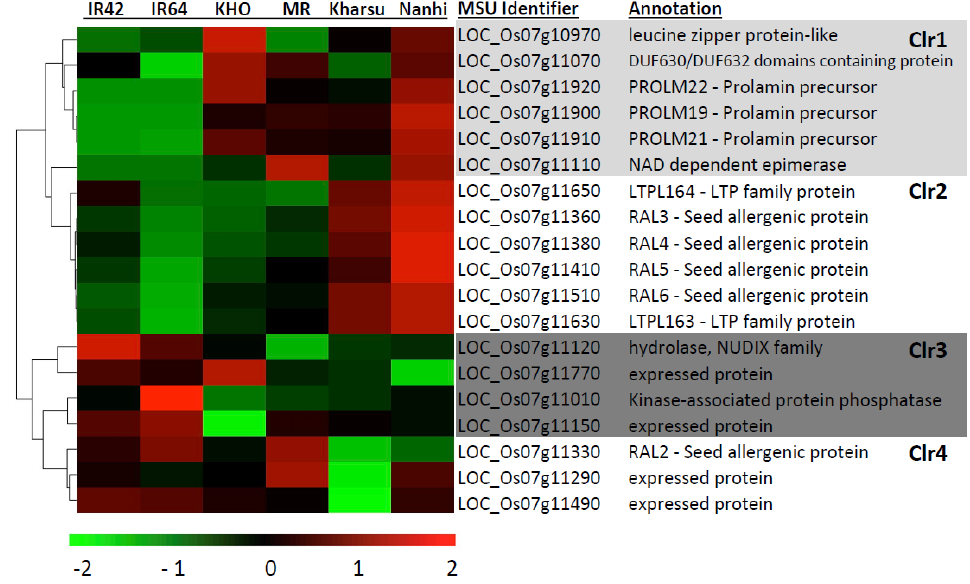
Figure 5. Heat map and the hierarchical clustering of differentially expressed genes (DEG) within the AG2 peak region. The heat map shows the log2FC of relative gene expression within the region across all six accessions. The default transformation method, rlog of deseq2 package [28] was used to transform the gene count output from StringTie (v.2.1.4). The rlog transformed value of gene counts scaled by library size was used to plot the heatmap. Red indicates up-regulation, green shows down-regulation, and black is neither up- or down-regulated. Clr = cluster.